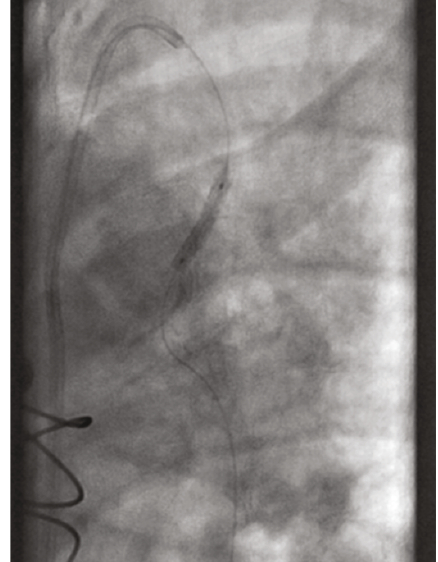
Figure 3: Stent placement within the left internal mammary artery bypass graft.